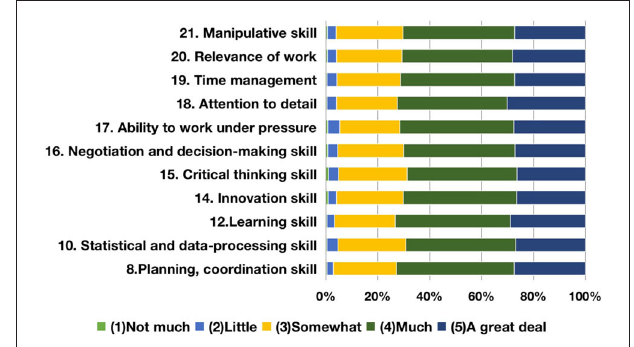
FIGURE 3 | Development of graduates’ professional skills.